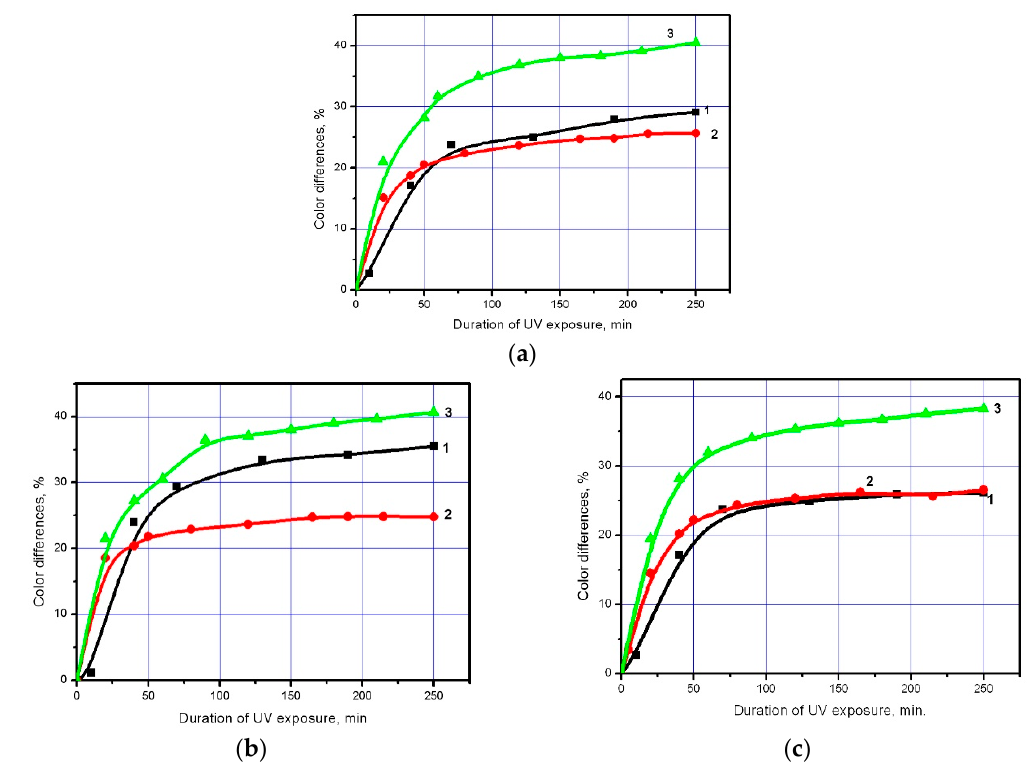
Figure 3. Colour differences in the eosin drop placedon a polyester fabric: 1—Coated with TiO 2 nanoparticles; 2—Coated with TiO 2 nanoparticles doped with iron; 3—Coated with TiO 2 nanoparticles doped with silver; ( a ) Nonactivatedpolyester fabric; ( b ) Polyester fabric pre-activated with a NaOH solution with a concentration of 3.75 g/L; ( c ) Polyester fabric pre-activated with surface-barrier discharge plasma for 5 s.